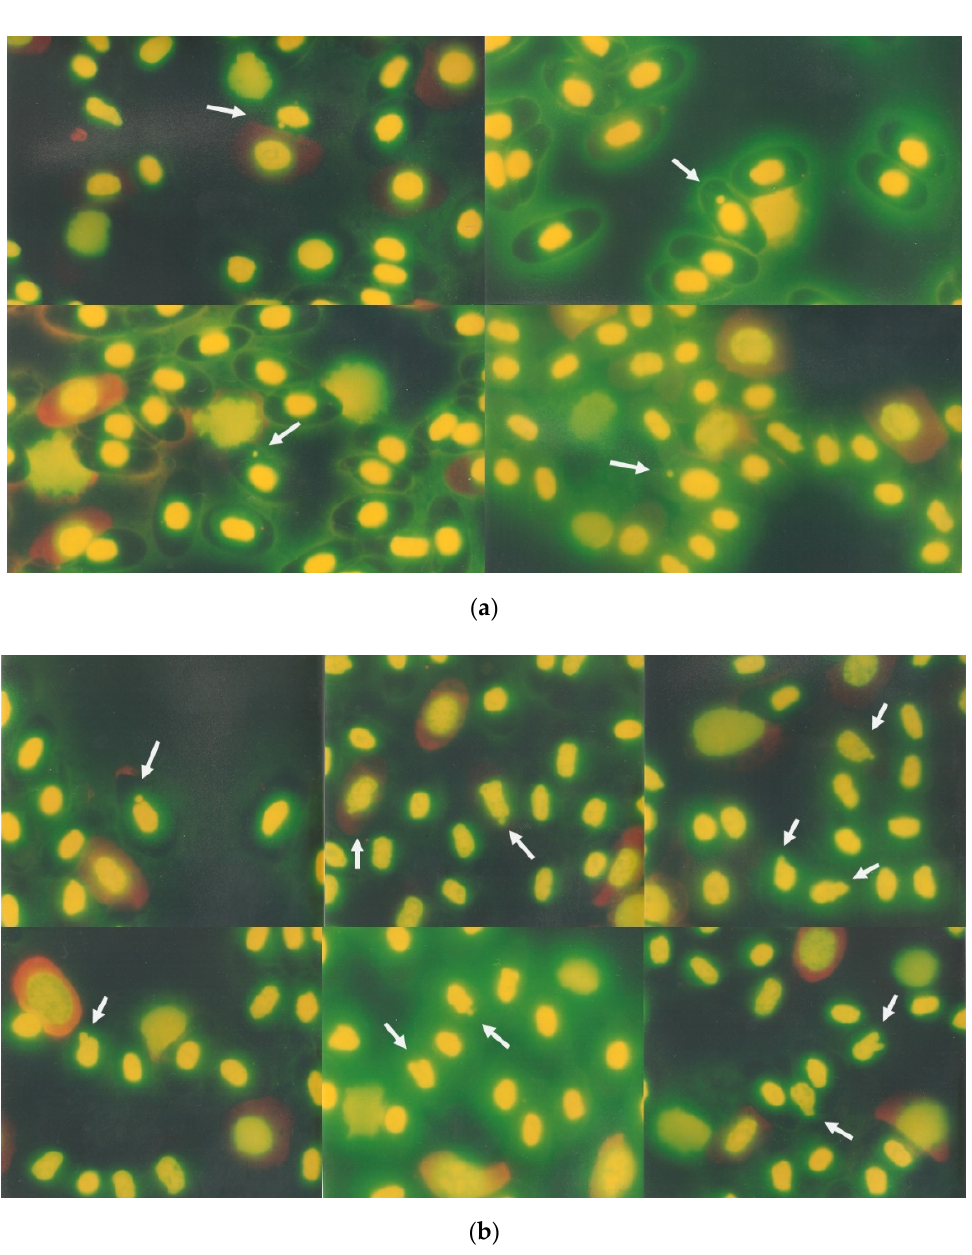
Figure 1. Erythrocytes with micronuclei (( a ) above) and nuclear buds (( b ) down) in peripheral crocodile blood sample were observed.